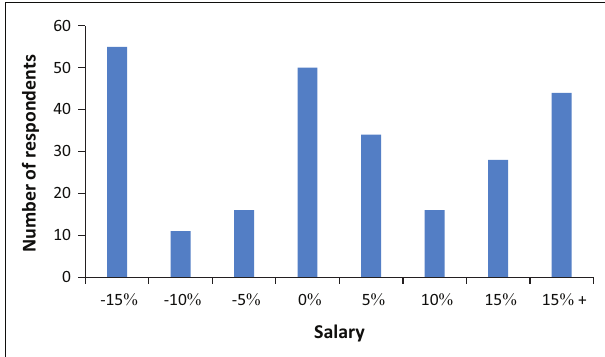
FIGURE 1: Frequency distribution for the level of salary for which an employee would consider moving to another organisation with a perceived strong employer brand.